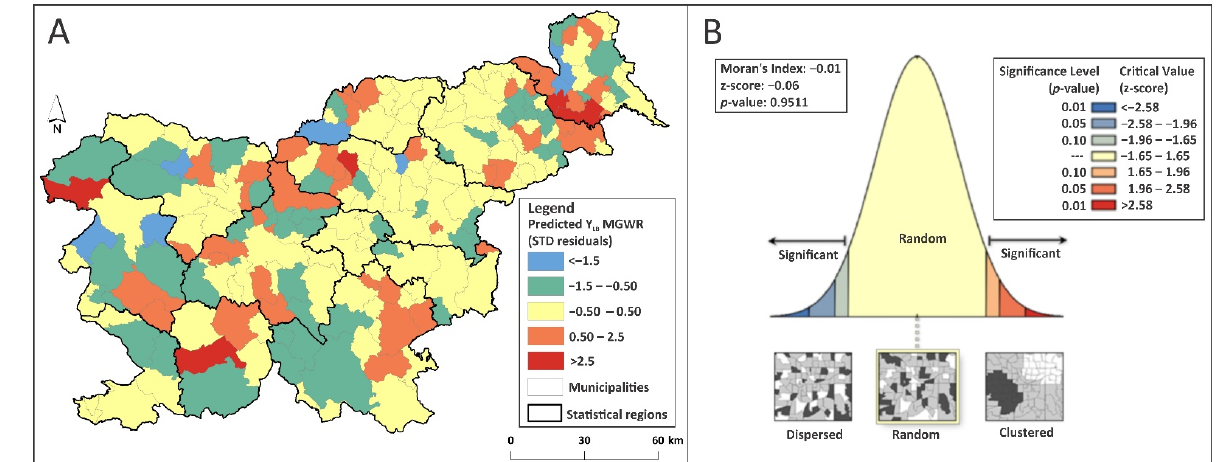
Figure 2. ( A ) Standardized residuals of predicted Y LB (MGWR model); ( B ) The corresponding spatial autocorrelation test.